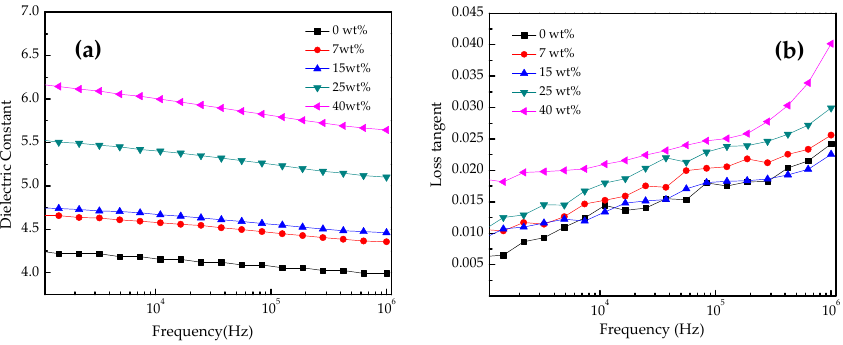
Figure 8. ( a ) The frequency-dependent dielectric constant and ( b ) the dielectric loss tangent of the pure epoxy resin ( ■ ) and the 7 ( ● ), 15 ( ▲ ), 25 ( ▼ ), and 40 wt % ( ◀ ) composites at room temperature.